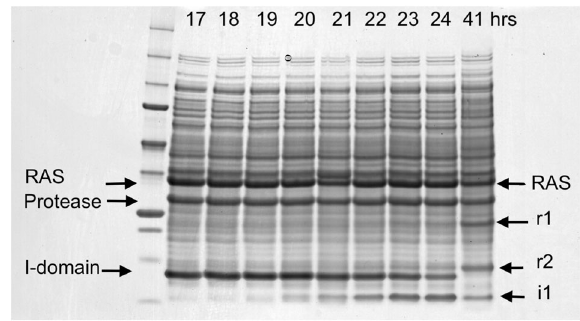
Fig. 7 RASProtease(I) with 100 µ M imidazole added to the culture media at 17 h. Intact RAS fusion protein is 35,974 daltons. The N- and C- terminal fragments of RAS are 13,579 (r2) and 22,413 daltons (r1), respectively. The C-terminal fragment of the I-domain is 6,175 daltons (i1). Markers: 250, 150, 100, 75, 50, 37, 25, 20, 15, 10 kDa.